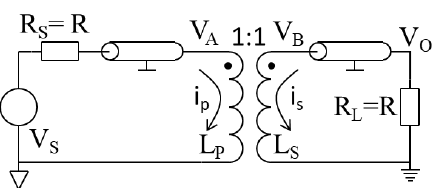
Figure 3. Configuration of an ideal transformer terminated at its input and